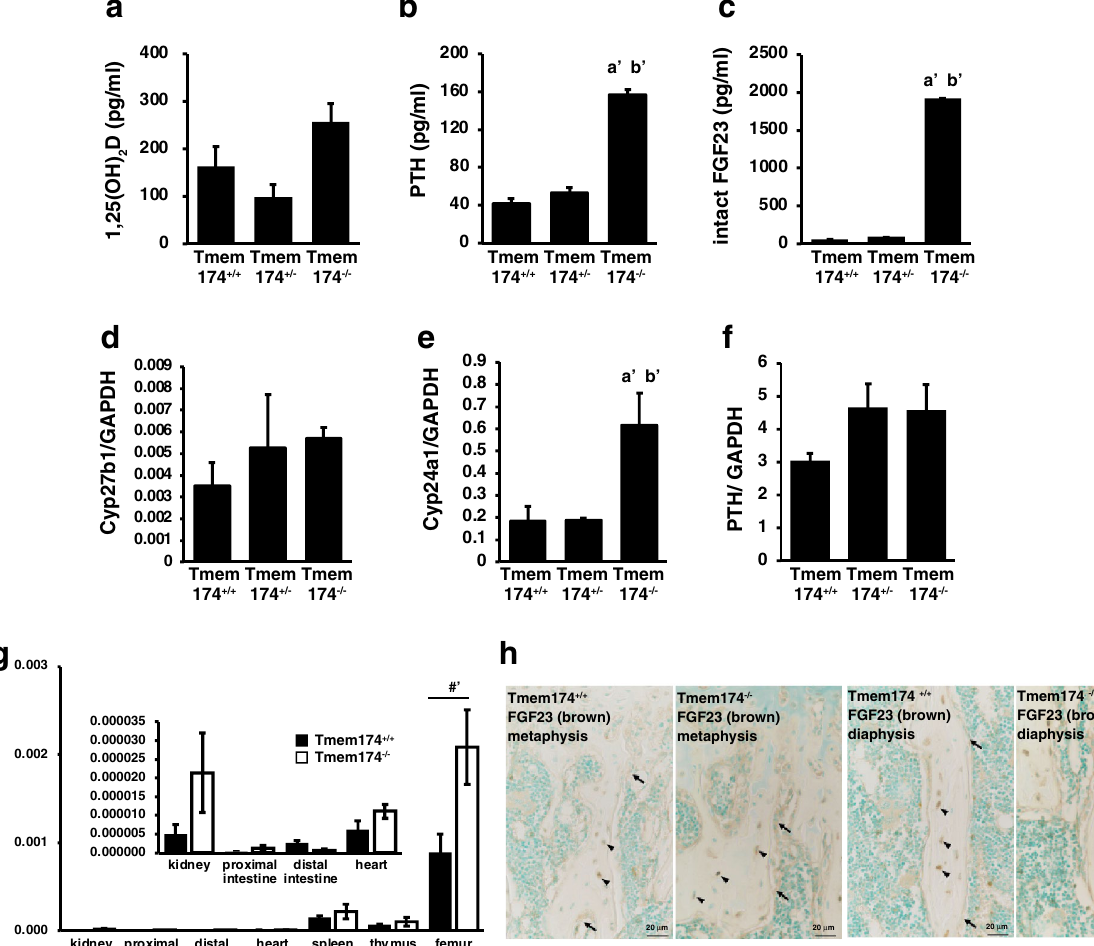
Figure 4. Effects of Deletion of Tmem174 on Pi homeostasis. ( a – c ) Plasma1,25(OH) 2 D, plasma intact PTH, serum intact FGF23 levels of Male Tmem174 +/+ , Tmem174 +/- , and Tmem174 −/− mice at 8–9 weeks of age. Values are mean ± SE (n = 10–20). a’ p < 0.01 vs. Tmem174 +/+ mice. b’ p < 0.01 vs. Tmem174 +/- mice. ( d – g ) Real-time PCR analysis. GAPDH was used as an internal control. Values are mean ± SE (n = 10–15). a’ p < 0.01 vs. Tmem174 +/+ mice. b’ p < 0.01 vs. Tmem174 +/- mice. #’ p < 0.01. ( h ) Immunohistochemistry of FGF23 (brown color) in metaphyseal and diaphysis trabeculae bones of Tmem174 +/+ and Tmem174 −/− male mice (8-week-old). Arrows: osteoblast/preosteoblast, arrowhead: